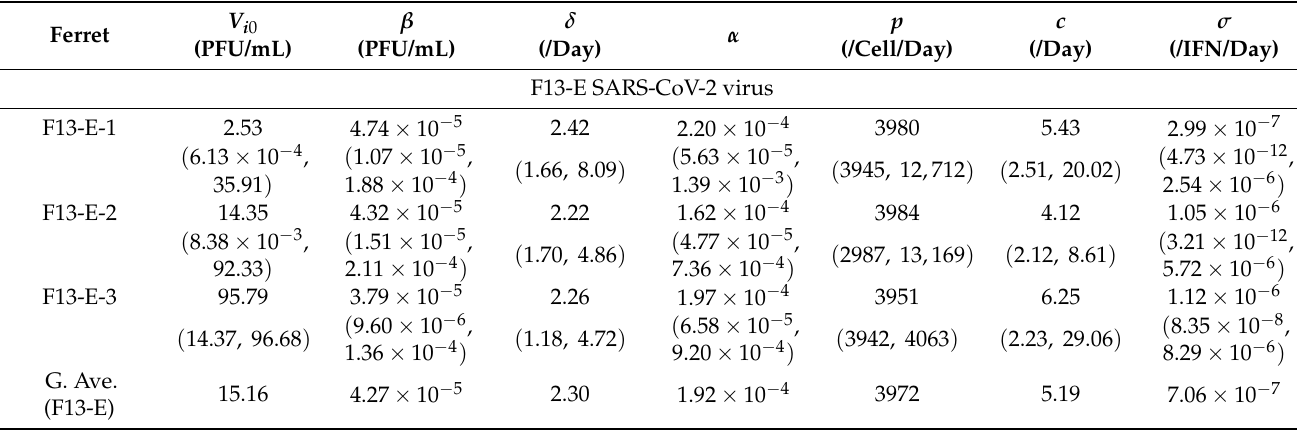
Table 3. Parameters of Model 3 estimated from the data fitting. G. Ave. stands for geometric average. p -values indicate the result of comparison between F13-E and CTan-H